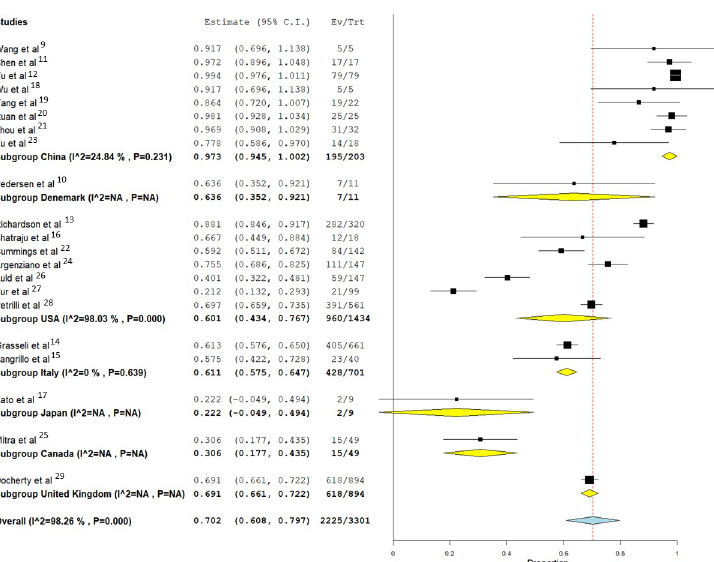
Fig 3. Forest plot of pooled analysis of mortality by random effect model in all studies of IMV with COVID 19 patients with subgroup division of country of origin.